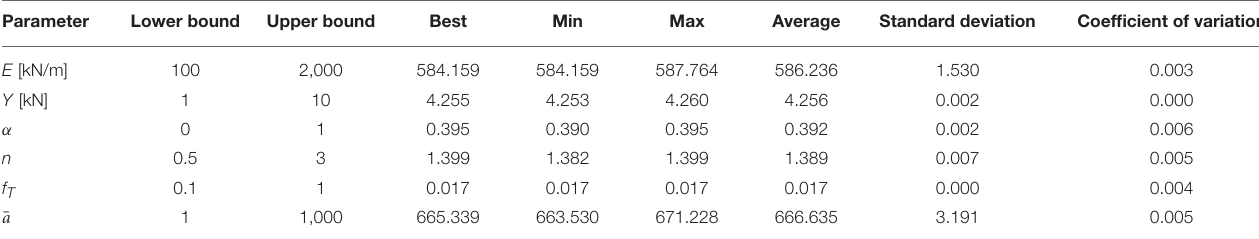
TABLE 3 | Statistical analysis of identified parameters of the proposed model for the experimental data obtained from Zhuang et al. (2016) shown in Figure 5C . Parameter Lower bound Upper bound Best Min Max Average Standard deviation Coefficient of